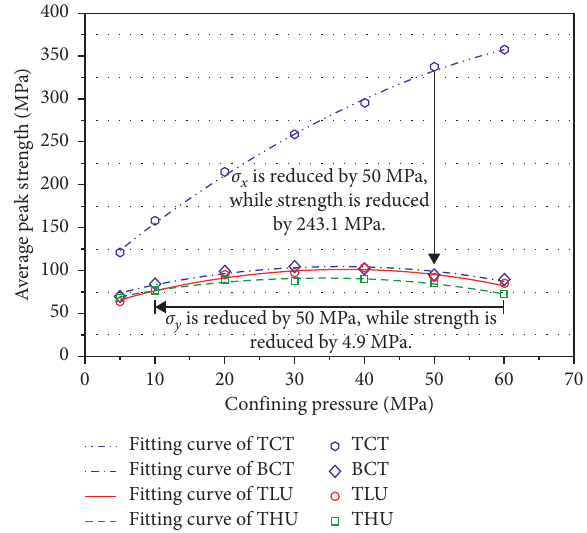
Figure 6: Relationship between the average peak strength and confining pressure.